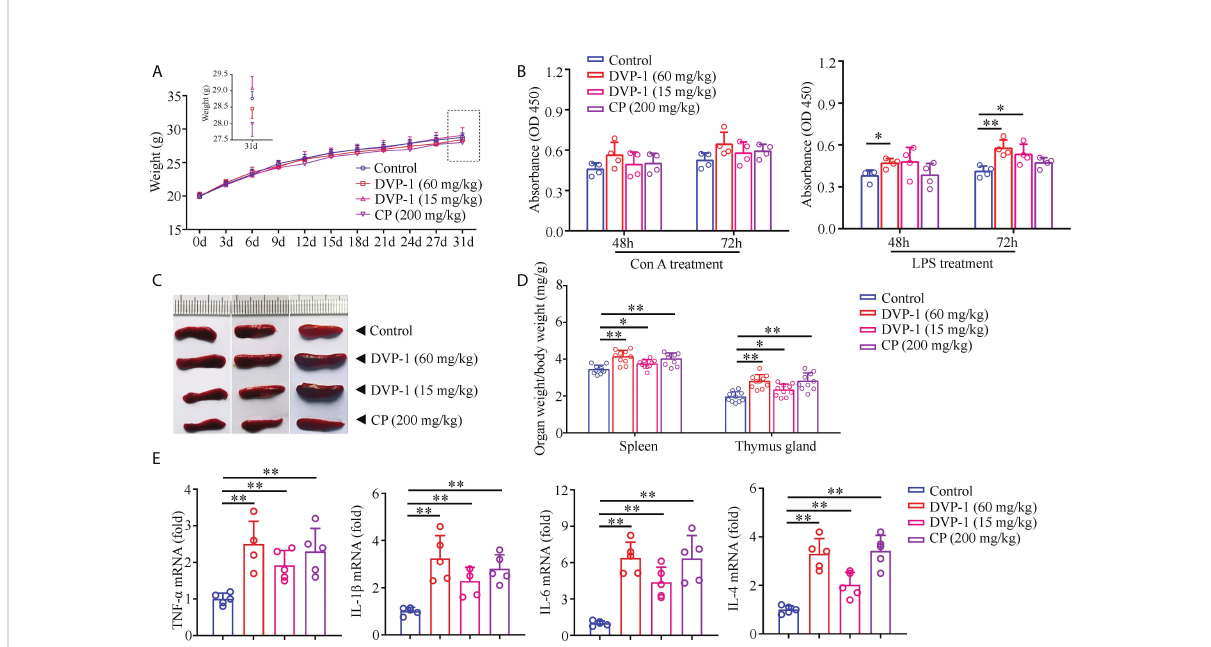
FIGURE 1 Immunomodulatory effects of DVP-1 in vivo . (A) Weight changes of mice in each group in 30 days. (B) General view of the spleen tissue after anatomy. (C) Immune organs index (spleen and thymus). (D) Lymphocyte proliferation stimulated by Con A or LPS. (E) Level of cytokine mRNA in the spleen using real-time PCR. *p < 0.05, **p <